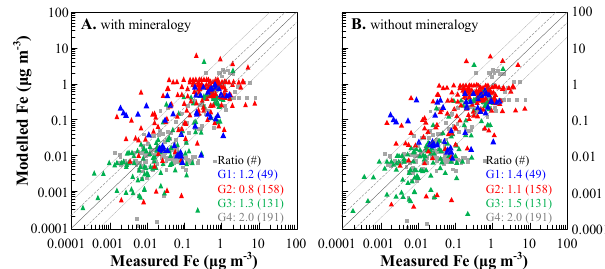
Figure 14. Plots of modelled and measured Fe concentrations at- tached to aerosols in surface air. The Fe content of dust was calculated from the new mineralogical data (a) or prescribed as 3.5% (b) . All stations were divided into four groups based on the relative differences between (a) and (b) : G1, difference ≥ 30% (blue triangles); G2, 20% ≤ difference<30% (red triangles); G3: 10% ≤ difference<20% (green triangles); G4, difference<10% (grey squares). The ratios between measured and modelled concen- trations as geometric means are listed with the number of stations in parentheses for each